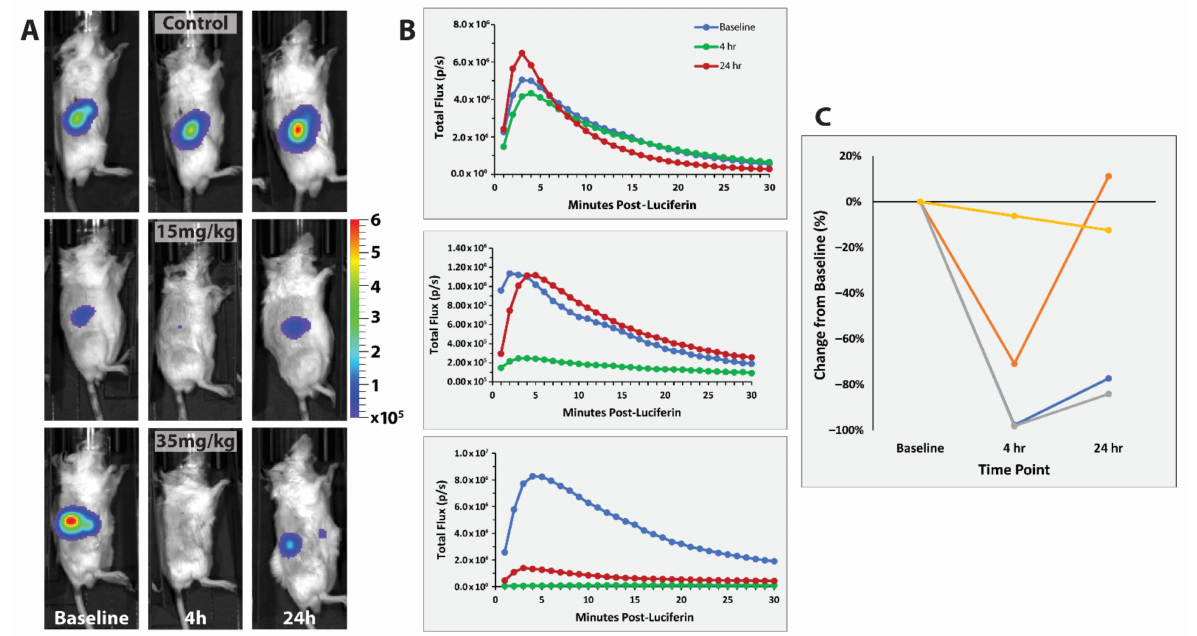
Figure 7. Vascular disruption assessed in RENCA-luc tumors using dynamic BLI. Effect of OXi6197 on RENCA-luc tumors growing orthotopically in the right kidney of syngeneic BALB/c mice. ( A ) Top row. Light emission observed from control tumor about 5 min after administering luciferin at baseline and 4 h and 24 h after saline. Middle row) Similar to A, but for a mouse which received OXi6197 (15 mg/kg IP). Bottom row) Similar to B, but for a mouse receiving 35 mg/kg OXi6197. ( B ) Curves showing evolution of light intensity at various times following OXi6197. Baseline (blue), 4 h (green) and 24 h (red). ( C ) Comparison of relative signal intensity indicating dose response for four tumors dosed with saline (control), 15 mg/kg and 35 mg/kg (including one small and one large: 0.97 g and 2.7 g, respectively, as determined upon sacrifice and excision).